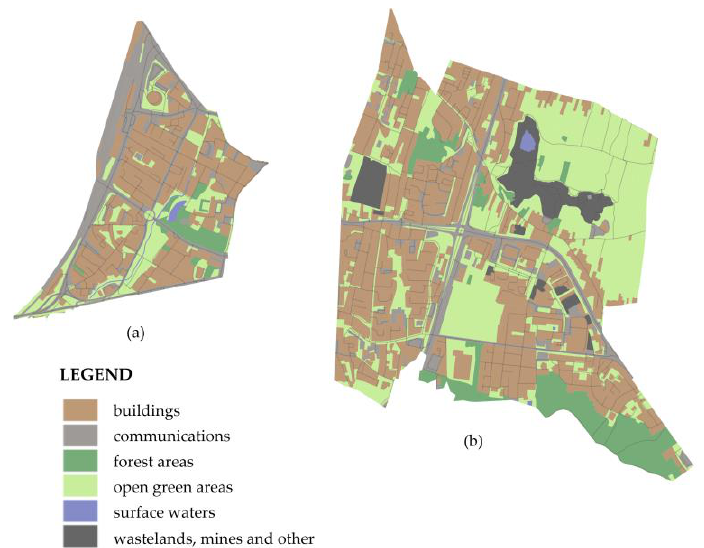
Figure 9. Development of the analyzed research areas: ( a ) area no. 16; ( b ) area no.